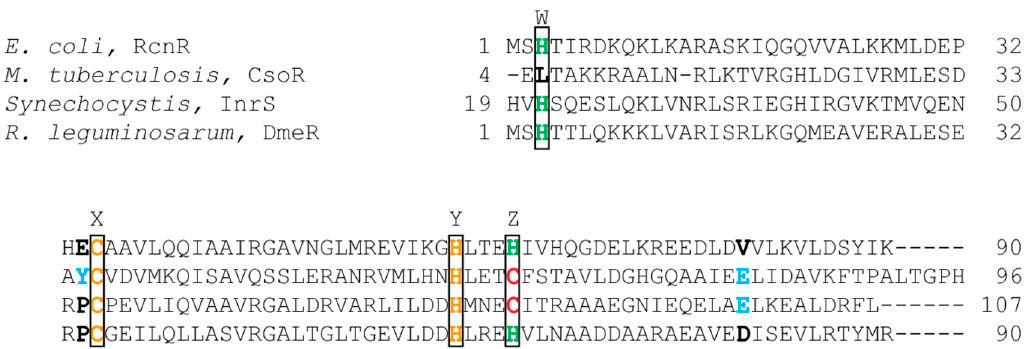
Figure 6. Sequence alignment of E. coli RcnR with M. tuberculosis CsoR, Synechocystis PCC 6803 InrS, and R. leguminosarum DmeR. Fingerprint residues (W,X,Y,Z) found in all four proteins are shown in orange while those that are unique to CsoR and RcnR are in red and green, respectively. The residues that form a hydrogen bonding network with His61, Tyr35 and Glu81, in M. tuberculosis CsoR are shown in blue, The sequence alignment was generated with Clustal Omega [71].